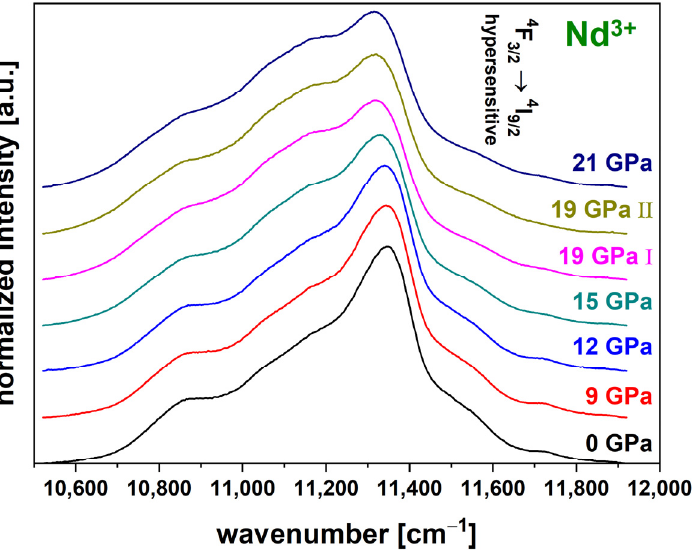
Figure 5. Luminescence spectra of the hypersensitive transition 4 F 3/2 → 4 I 9/2 of the Nd 3+ -luminescence for the permanently densified glasses (0 GPa to 21 GPa); spectra were acquired with a 780 nm laser; a clear broadening of the left shoulder next to the maximum peak can be seen and consequent shifting of the centroid position to a lower wavenumber.